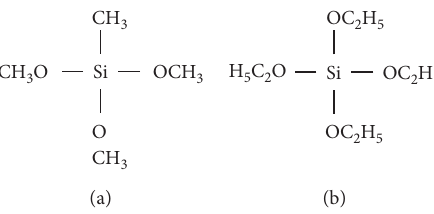
Figure 1: Chemical structure of (a) alkyl alkoxy silane and (b) tetraethoxy